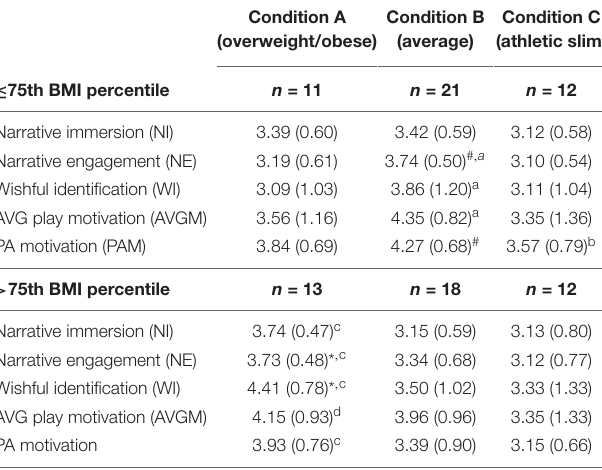
TABLE 2 | Means of the main outcome variables per group ( N = 87).